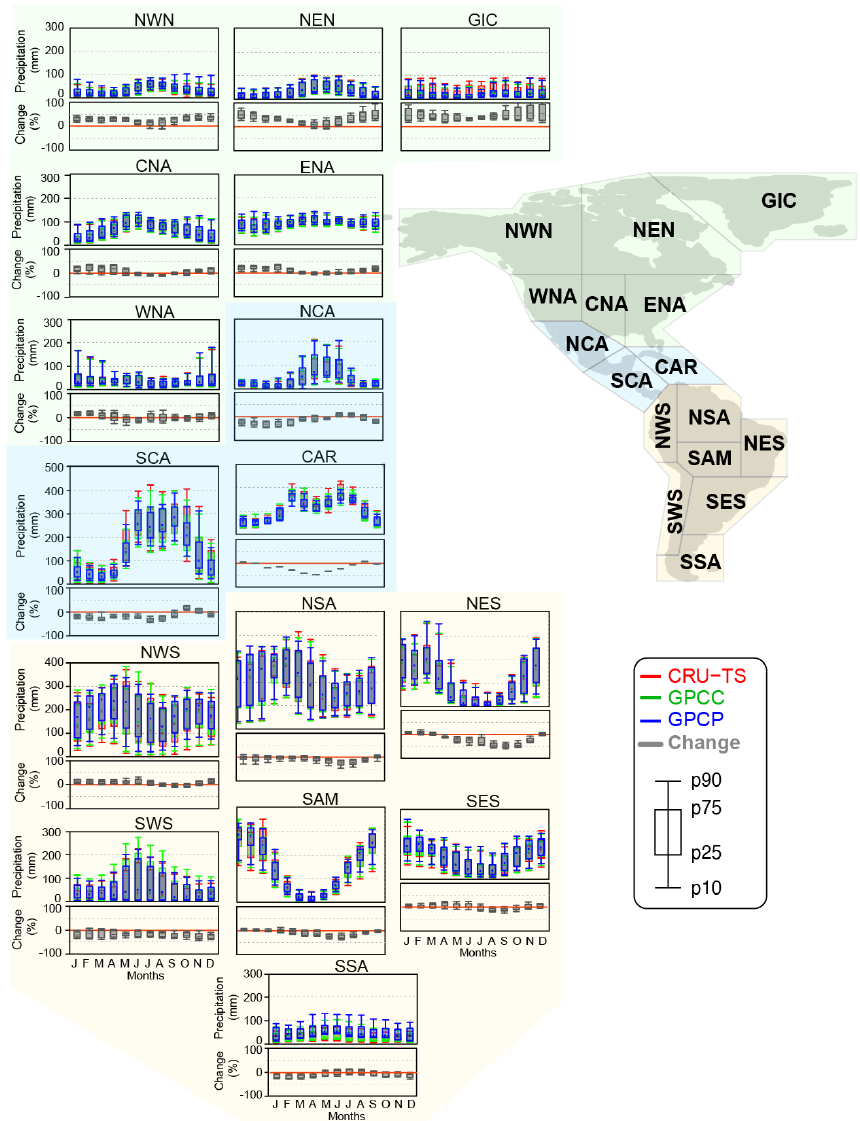
Figure 3. Observed annual cycle (1981–2010) for precipitation for the American reference regions from three different observational datasets (CRU-TS, GPCC, GPCP) and climate change signal (RCP8.5, 2081–2100, w.r.t. the AR5 modern climate baseline 1986–2005). The panel for each reference region shows the observed annual cycle (top, in monthly accumulated millimetres) and the monthly projected changes (bottom, in grey, as percentages); box-and-whisker plots represent the spatial (grid box) spread of monthly values over the